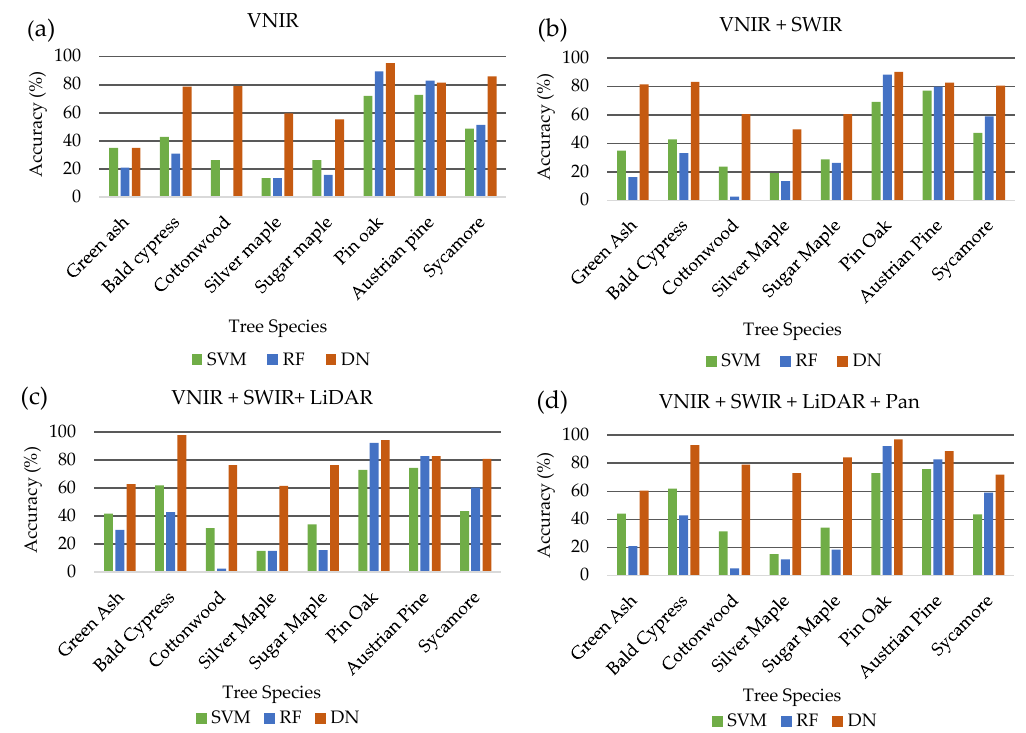
Figure 7. Overall accuracies for individual tree species using SVM, RF, and DenseNet (DN) classifiers using ( a ) eight VNIR WorldView-2 bands, ( b ) 8 VNIR WorldView-2 bands plus eight SWIR WorldView-3 bands, ( c ) eight VNIR WorldView-2 bands plus eight SWIR WorldView-3 bands plus LiDAR intensity return image and ( d ) eight VNIR WorldView-2 bands plus eight SWIR WorldView-3 bands plus LiDAR intensity return image plus WorldView-2 panchromatic